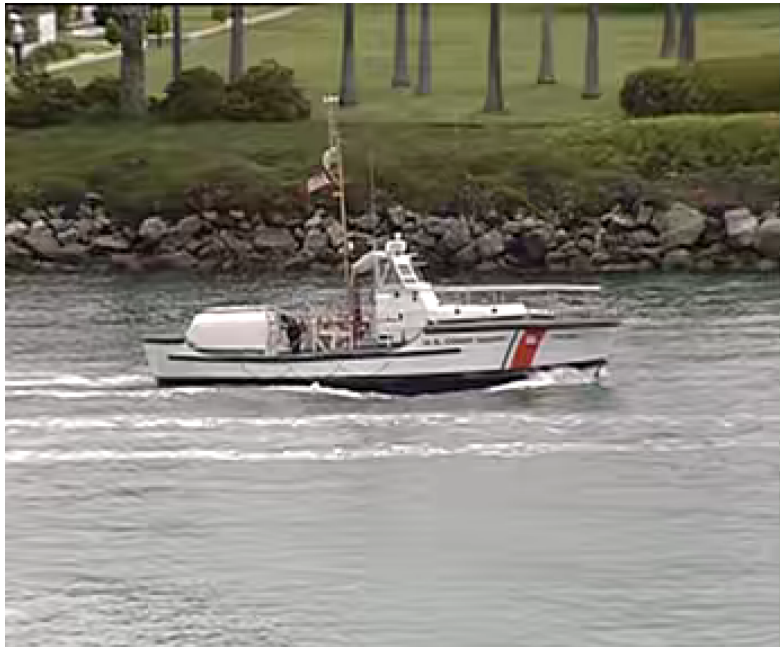
Figure 15. Frame of output video from HM with DBF enabled.